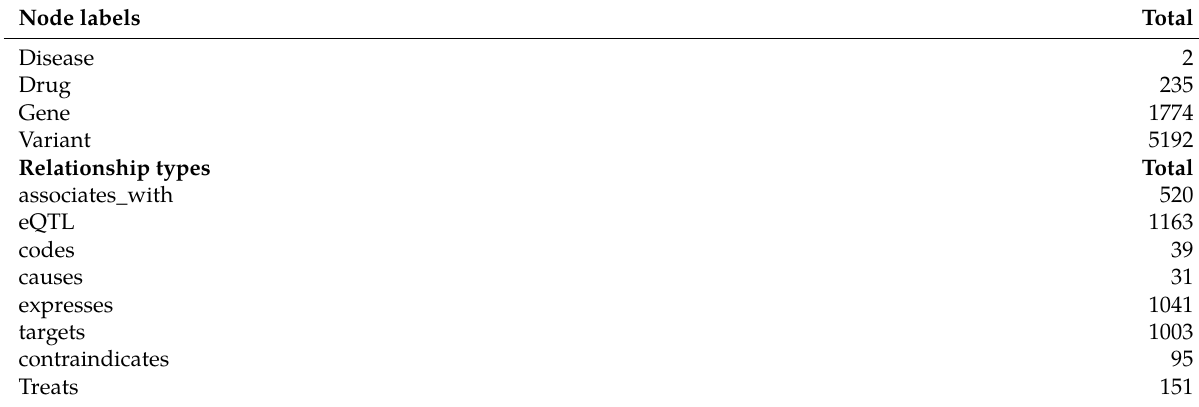
Table 1: Total number of nodes and